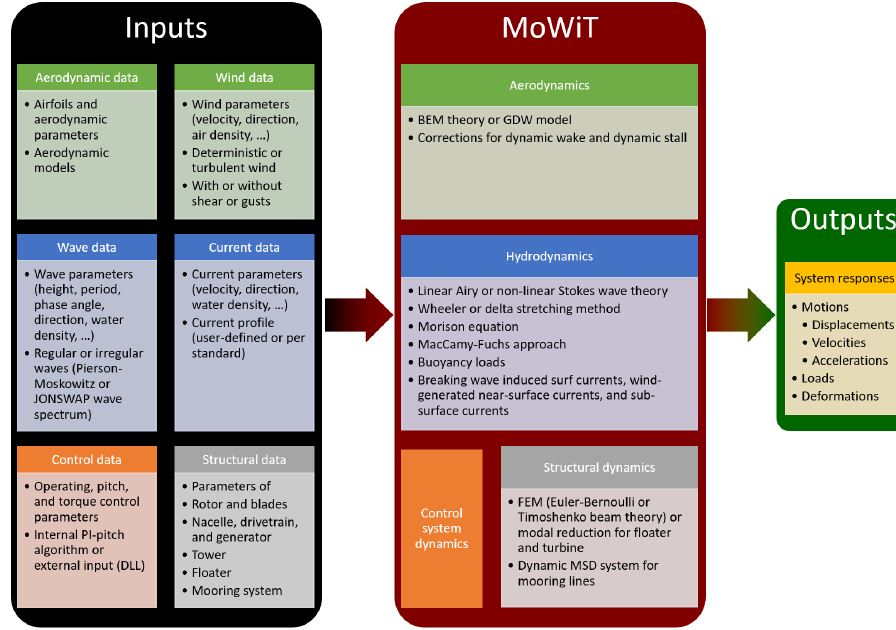
Figure 6. Flowchart representing the structure of the MoWiT model with inputs and